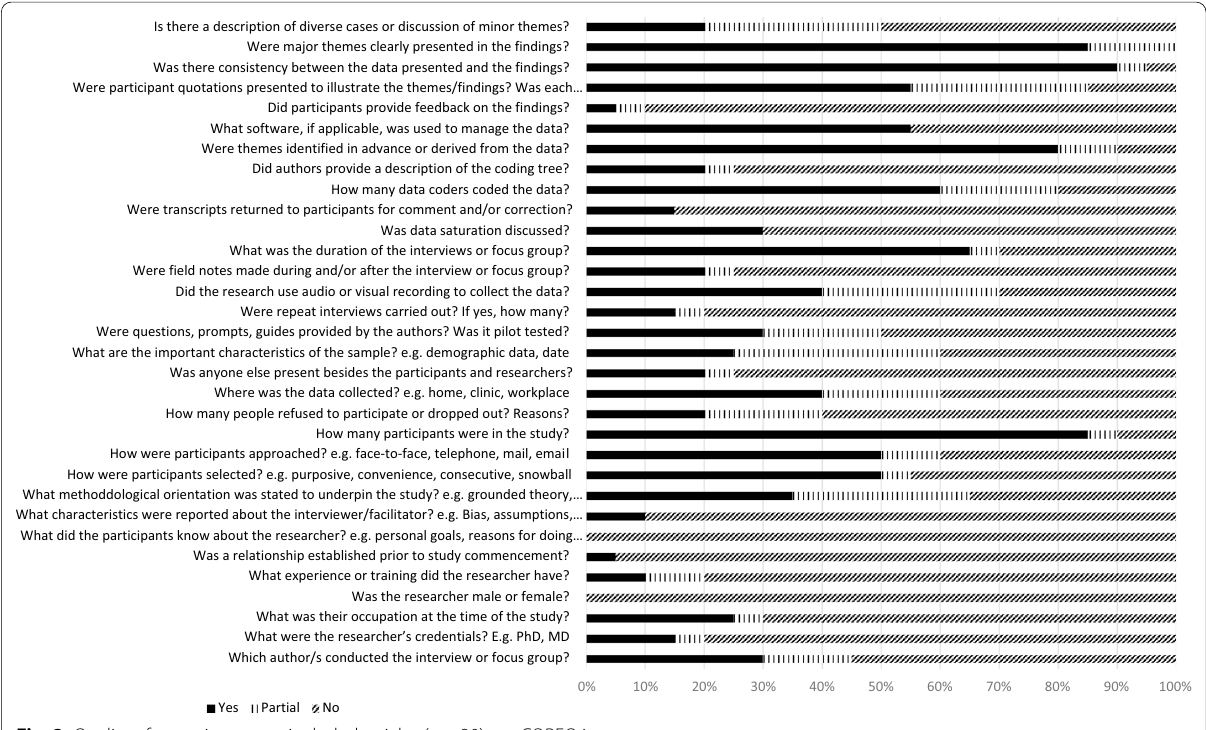
Fig. 2 Quality of reporting across included articles (n